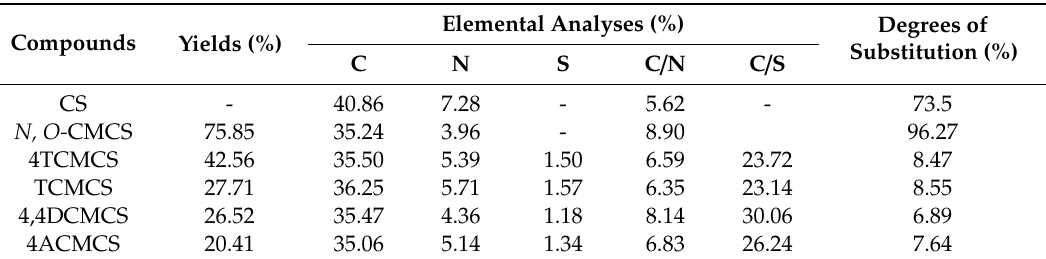
Table 1. The elemental analyses, yields, and the degrees of substitution of CS, N, O- CMCS, and Carboxymethyl chitosan containing thiourea salts. Elemental Analyses (%) Degrees of Compounds Yields (%) Substitution (%) C